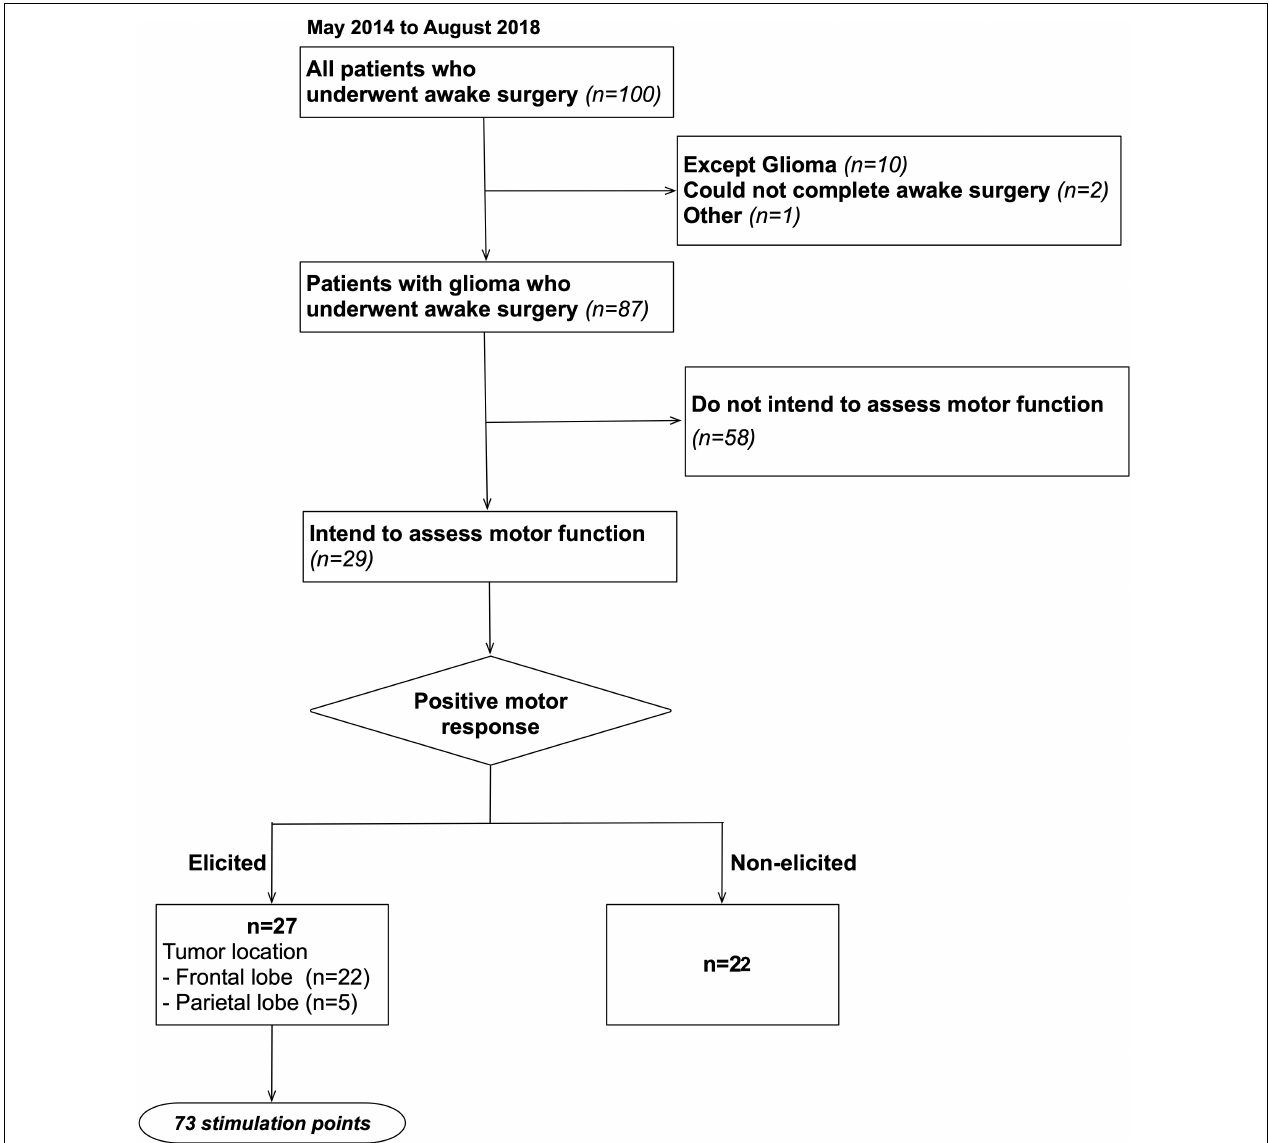
FIGURE 1 | Inclusion criteria. A total of 100 patients who underwent awake surgery in our university were included, and 87 of these patients matched our inclusion criteria. Then, we studied 87 patients retrospectively and found that 29 patients were operated in awake condition intending to identify motor